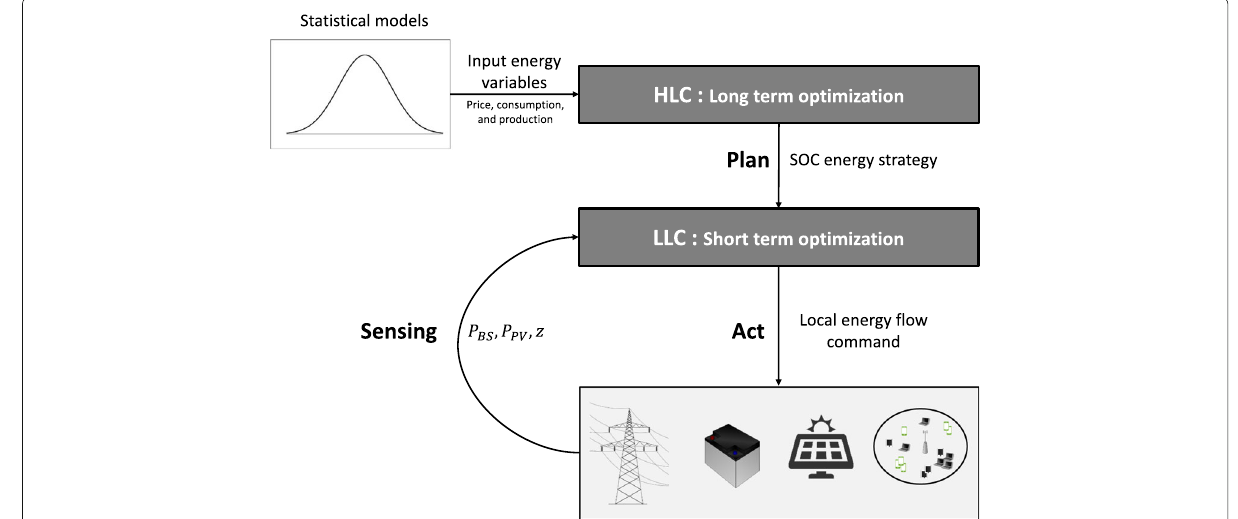
Fig. 3 Proposed cognitive energy supervision infrastructure